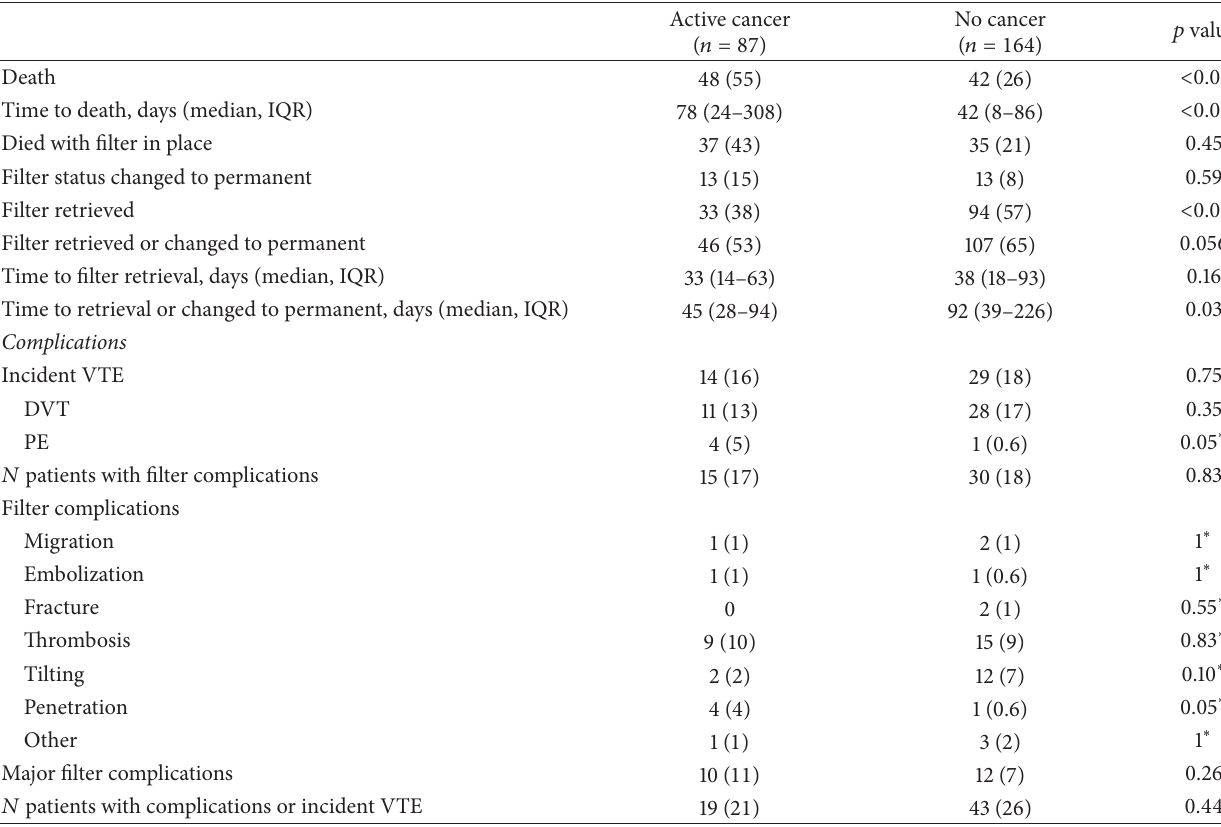
Table 2: Outcomes by active cancer